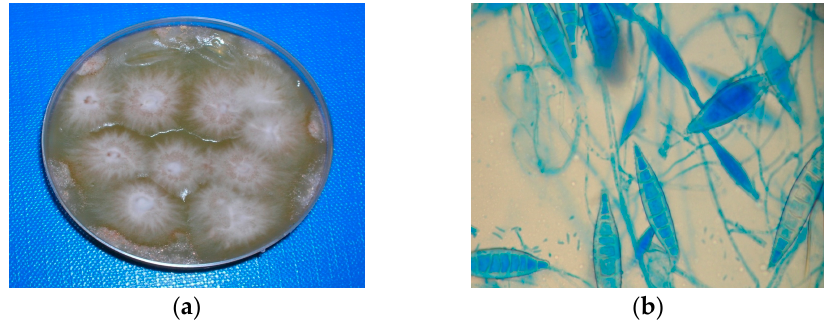
Figure 2. ( a ) Colonies of M. canis in culture; ( b ) Microscopic aspect, macro- and micro-conidia.